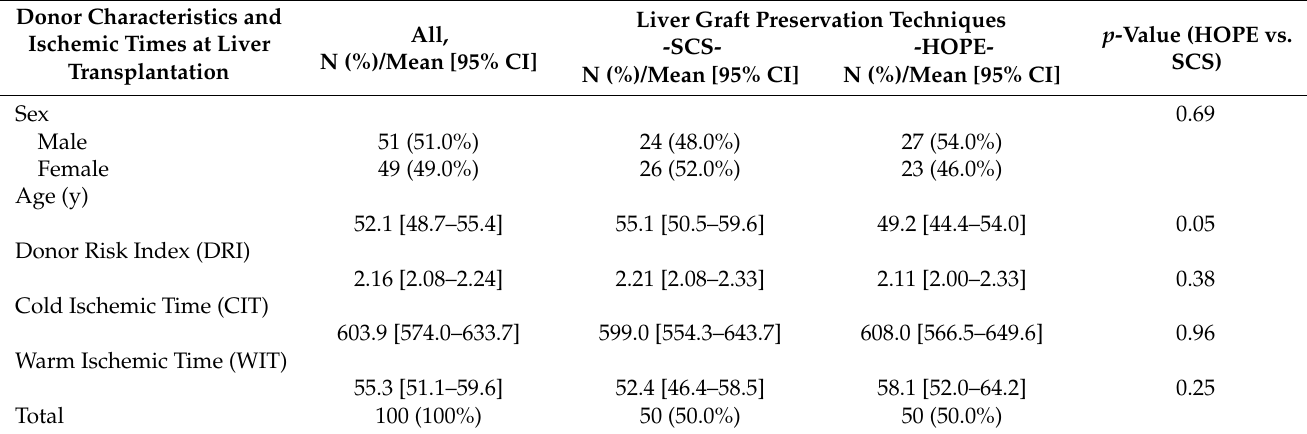
Table 1. Description of characteristics of liver graft donors and ischemic times of the respective grafts, stratified by liver graft preservation technique.